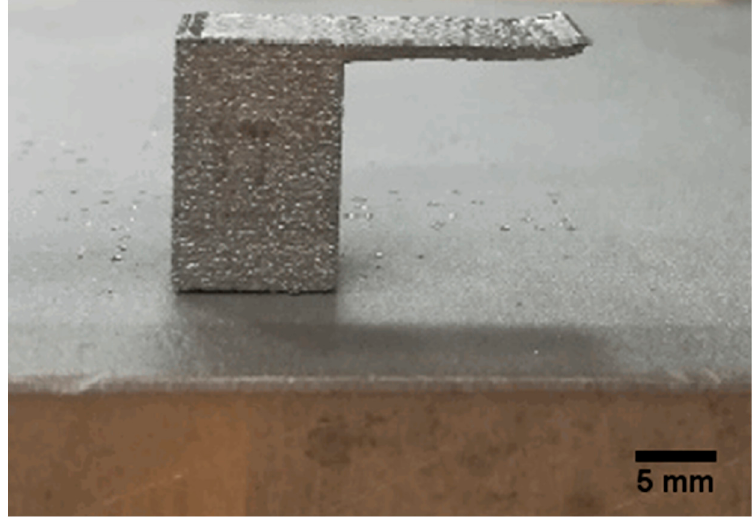
Figure 7. Model without support structure (model A) fabricated using EBM. Figure 8. Models with support structures (models B to E) fabricated using EBM.